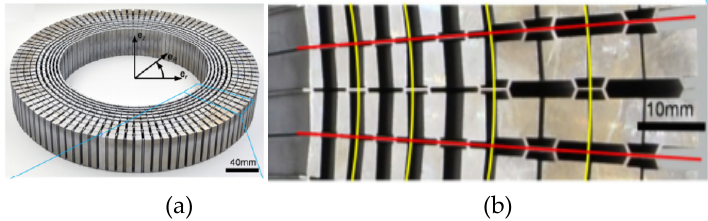
Figure 27. ( a ) Image of the cloak machined from an aluminum block; ( b ) Enlarged view of one segment, highlighted in ( a ) [91].